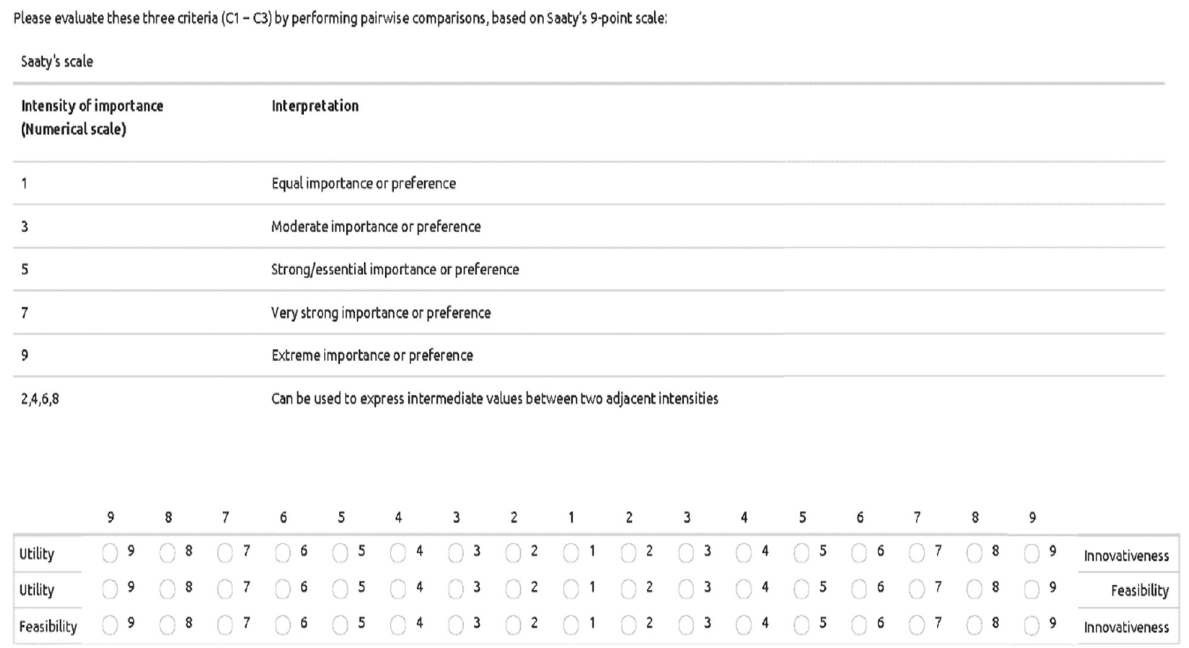
Fig. 1 Indicative cut screenshot of the online questionnaire: pairwise comparisons of the AHP